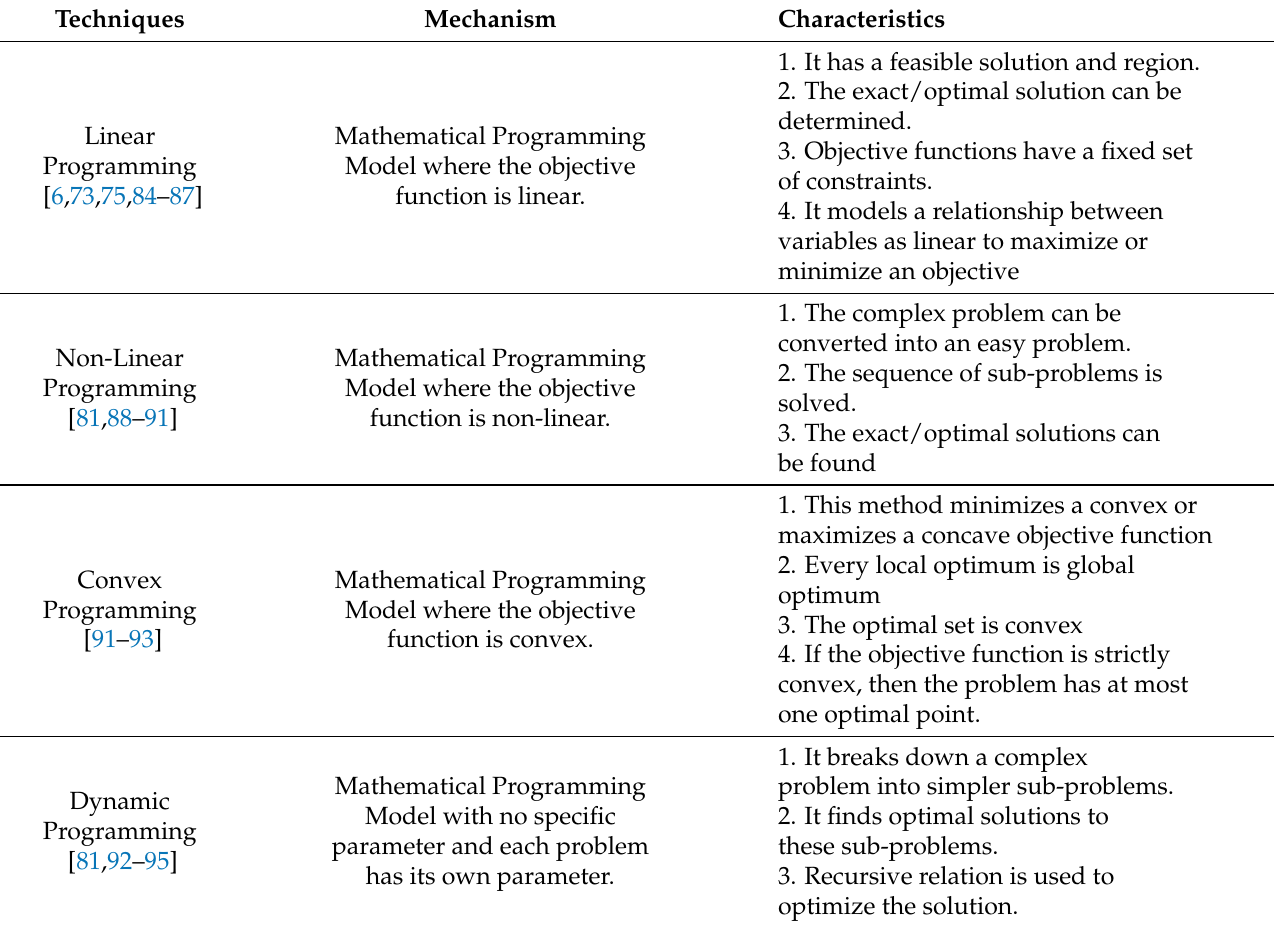
Table 5. Comparison of conventional optimization techniques. (Part of this table was adapted from